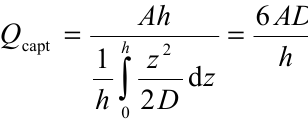
Figure 3. Suitable volumetric flow for efficient delivery of molecules to the sensor as a function of sensor size. The geometry is based on the channel in Figure 1 and the flow is calculated from Equation (5). A diffusion constant of 10 − 10 m 2 /s is assumed for the Brownian motion perpendicular to the surface. Flow rates higher than Q increase the delivery rate of molecules but relatively